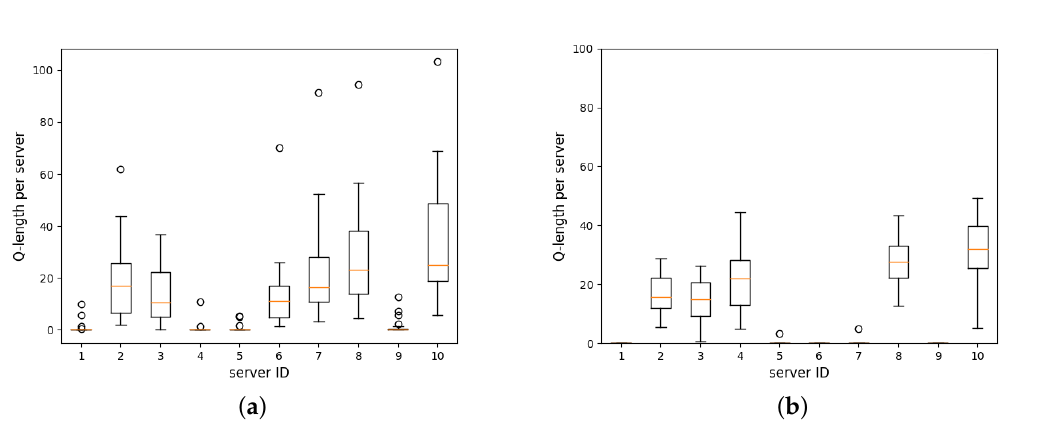
Figure 5. Distribution of the tasks queue length ( | N | = 10, ρ = 1.0). ( a ) REJO; ( b ) Proposed.